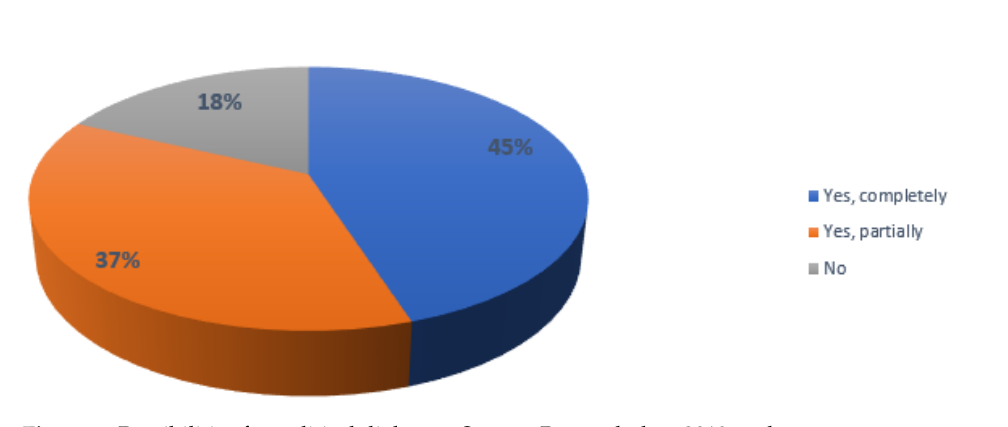
13 of 18 Figure 5. Role to be played with the local government. Source: Research data 2019-authors. This result is the consequence of many years of struggle with the local government where the LDAs have developed all kinds of activities from training, micro-credits, or- ganization of events, mapping of actors in the territory, conferences, debates, etc. Due to